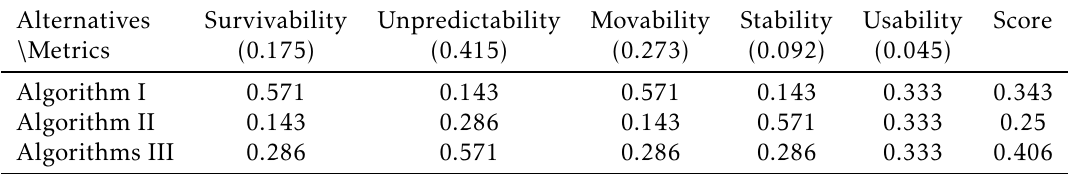
Table 2. Final scores for every algorithm